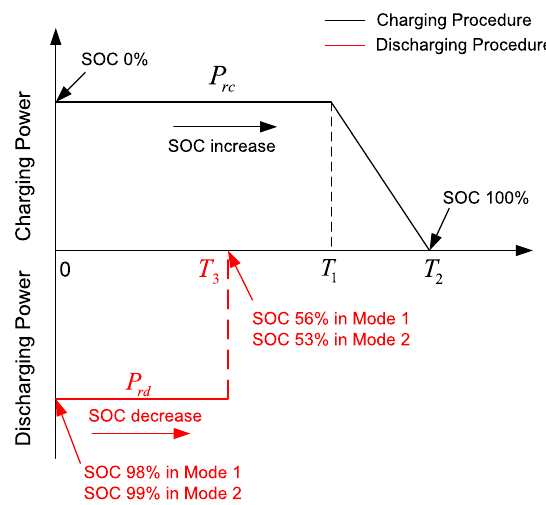
Fig. 1 Generic charging/discharging profile of lithium-ion EV batteries